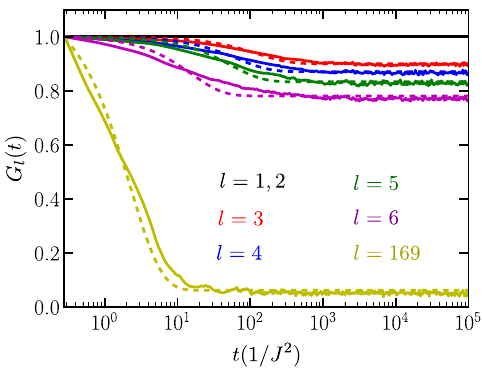
FIG. 3. Plot of the autocorrelation function G FIG. 2. Scatter plot of the smallest 30 of the 3 N ð N − 1 Þ = 2 disorder realization for N ¼ 13 spins at Δ ¼ 0 . 75 . The solid singular values σ at N ¼ 9 for Δ ¼ 1 (blue squares) and Δ ¼ 0 . 9 l curves represent the numerically computed G (red circles) in a fixed disorder realization of f J . At Δ ¼ 1 , we i g curve corresponds to either of the two exactly conserved bilinear see N þ 1 zeros corresponding to the N þ 1 conserved charges quantities; the red, blue, green, and magenta curves correspond to that can be written as a sum over bilinear operators; these zeros the next four modes (arranged by increasing singular value); the are separated from the rest of the singular values by a “ spectral ” yellow curve corresponds to a mode in the middle of the singular gap. At Δ ¼ 0 . 9 , we see two zeros corresponding to the value “ spectrum. ” The dashed curves represent fits of the form 2 . We also see the lift-off of conservation of H and ð S z ˜ tot Þ N − 2 singular values corresponding to the previously conserved bilinear charges at Δ ¼ 1 . Note that they, too, are separated from the rest by a “ spectral ” gap.